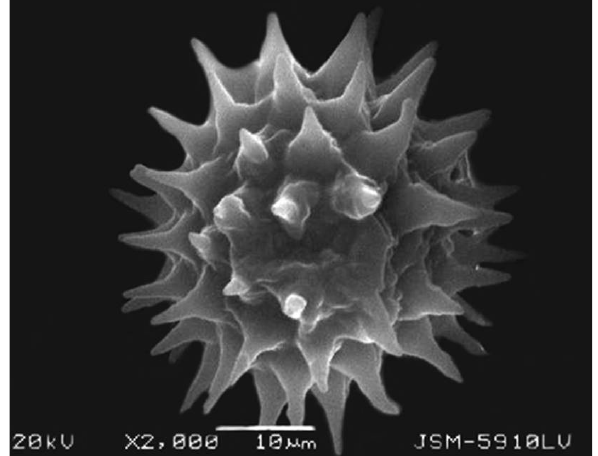
Fig. 8. Scanning electron micrographs of pollen grain to show exine pattern in H. annuus L. Bar: 10